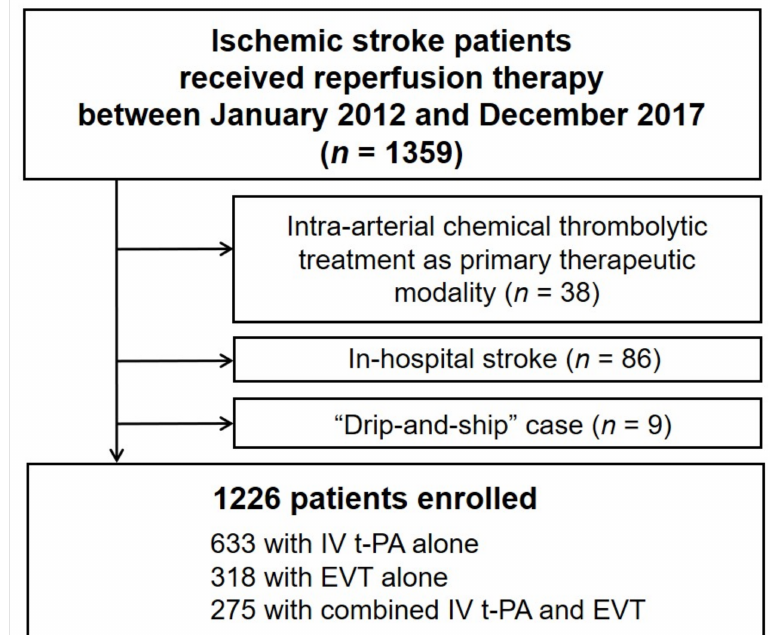
Figure 1. Flow diagram for the selection of patients in this study. IV, intravenous; t-PA, tissue plasminogen activator; EVT,